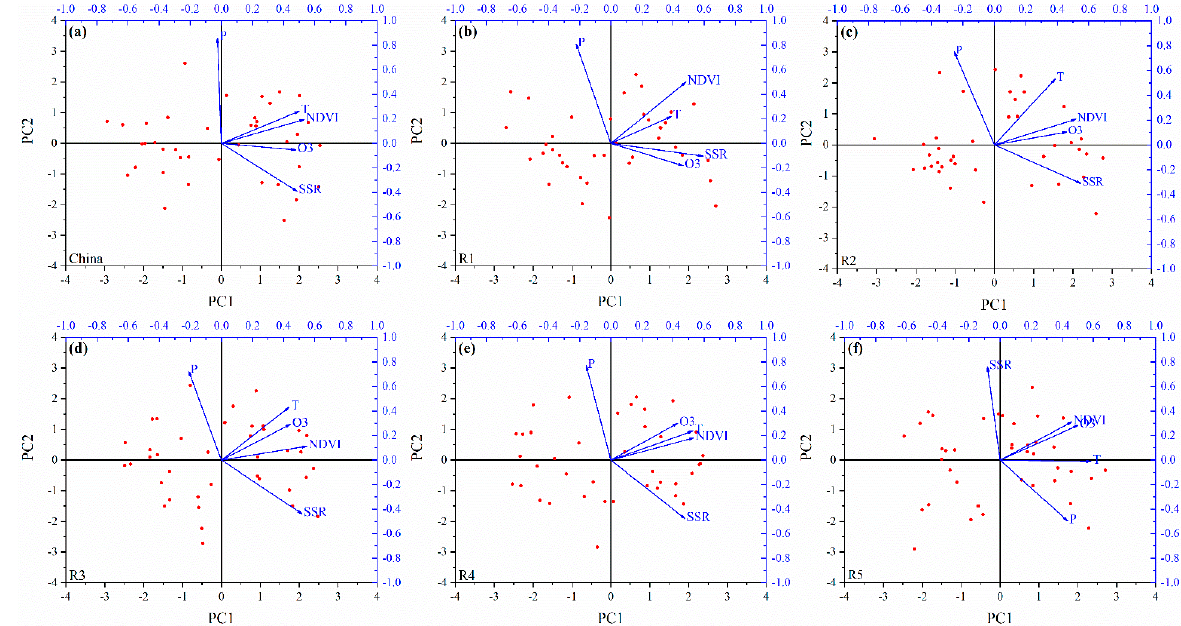
Figure 6. Relationships between NDVI and OMR (O3 refers to OMR) and climate elements (T, P, SSR) during 1982–2020. The graphs are based on PCA results. ( a ) presents relationships over China. ( b – f ) are relationships over ozone pollution region of R1, R2, R3, R4 and R5, respectively.